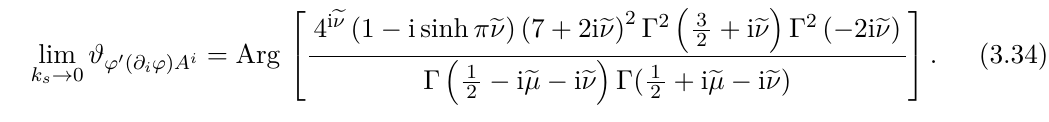
ν and the chemical e µ, ν ) e e